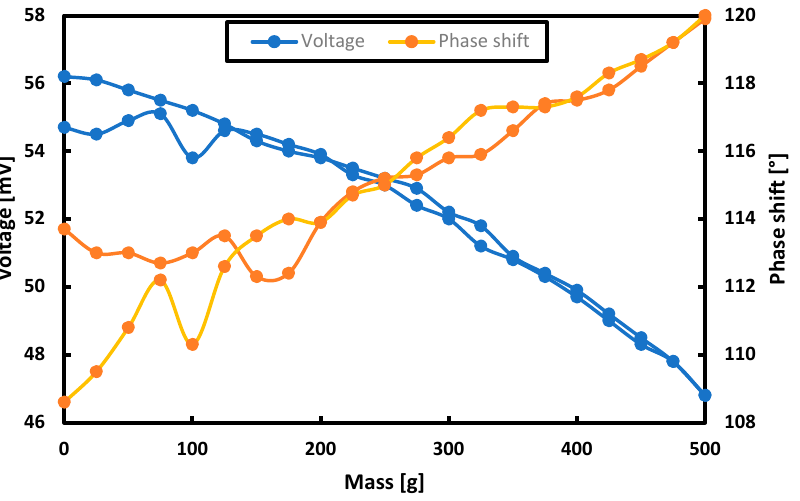
Figure 9. The results of the measurement of the signal amplification measured at the given loads for successive harmonics.